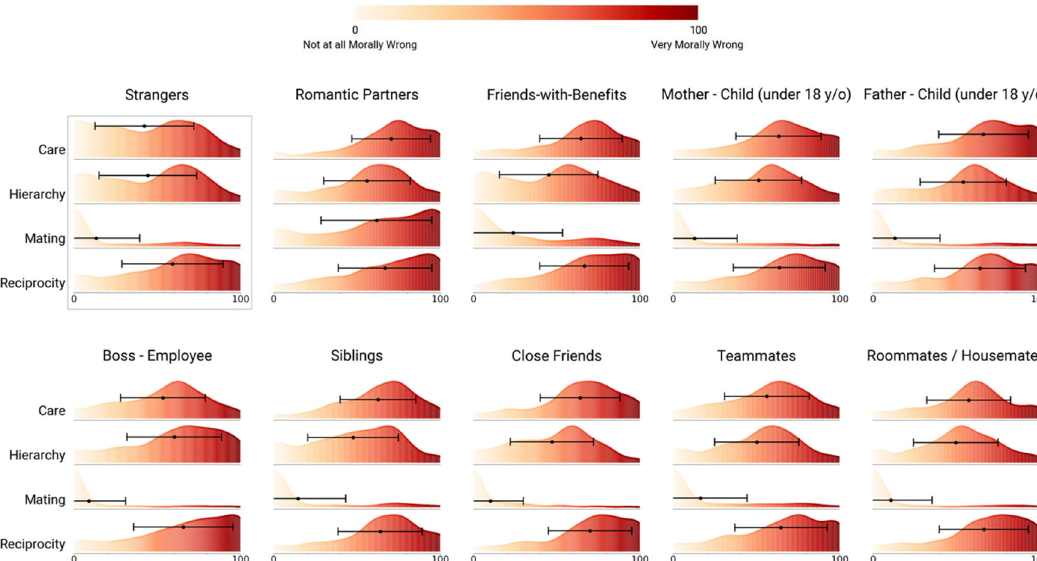
Fig. 5 Moral wrongness judgments. Sample 2 moral wrongness judgments for cooperative function violations in different relationships: kernel density plot of wrongness judgments (0 = not at all morally wrong, 100 = very morally wrong) concerning characteristic function-weakening actions for each of four dyadic cooperative functions across 10 relationships. Dot represents the mean, with 95% con fi dence intervals. Height of the curve represents density (see Fig. 1 for explanation). This experiment was conducted once, with all data shown here. Note that actions which characteristically weaken the mating function (e.g., refusing to have sex with someone) were judged closer to “ not at all wrong ” than “ very wrong ” for all dyads apart from the romantic partner relationship. Otherwise, the relative lack of visually dramatic differences in the shape of the moral wrongness judgment distributions between relationships likely can be explained by the mild or “ everyday ” nature of the function-weakening actions employed in this study (see Fig. 4). Such actions were deliberately chosen to contrast with the more extreme, unusual, or bizarre actions often studied in moral psychology; thus, the ability of our model to predict even subtle variance in moral wrongness judgments between relationships for common, non-extreme actions (see analysis below) can be seen as a strength. Source data are provided as a Source Data fi le.